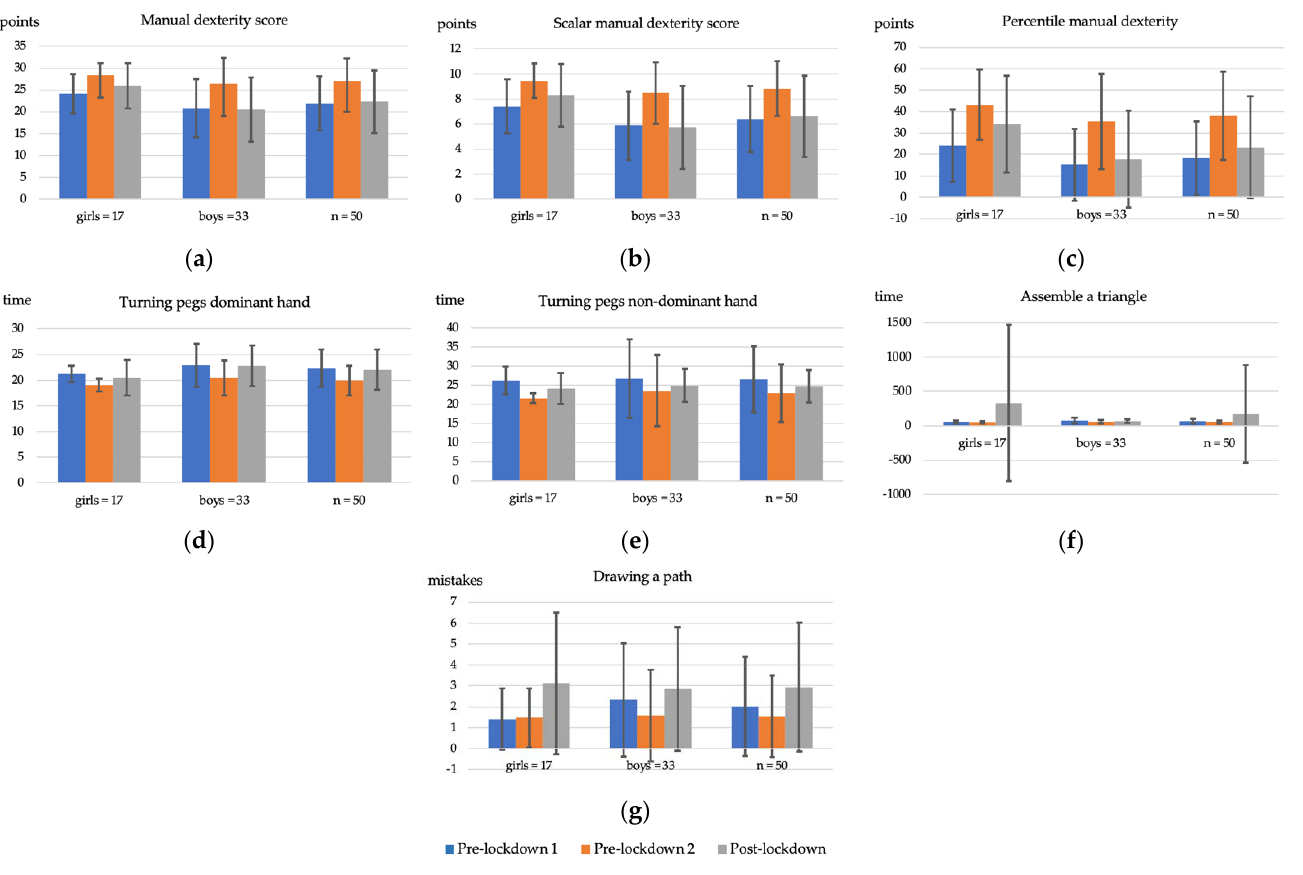
Figure 1. Columns of the evolution of mean manual dexterity scores and their different tests with standard deviation bars. ( a ) Manual dexterity dimension score. ( b ) Manual dexterity scalar dimension score. ( c ) Manual dexterity percentile. ( d ) Flipping pegs preferred hand. ( e ) Flipping pegs non- preferred hand. ( f ) Setting up a triangle. ( g ) Drawing the layout.